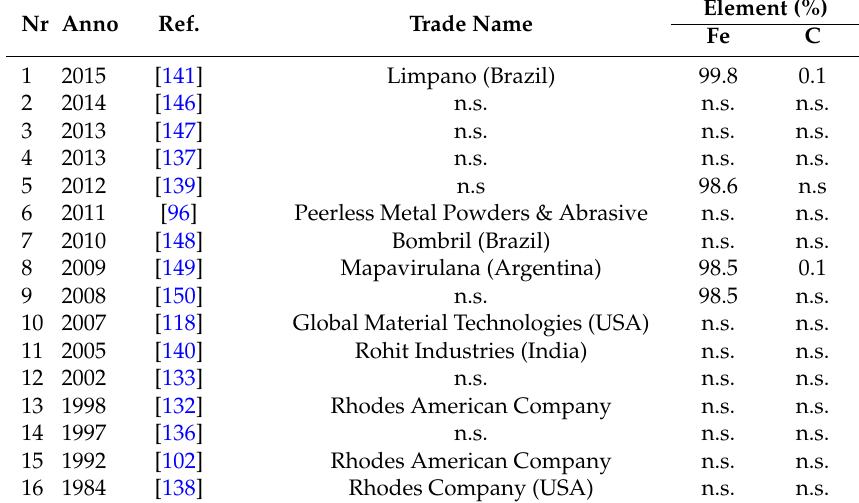
Table 2. Summary of trade names, iron and carbon contents of 14 peer-reviewed articles using steel wool for contaminant removal. It is seen that only four articles have specified the composition of used steel wools while seven have not specified the trade name of their used specimens. “Nr” is the number referencing individual articles in Tables 3–5. Nr Anno